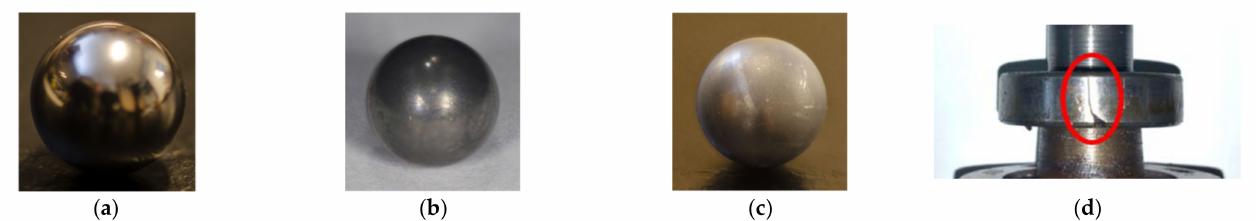
Figure 3. Representation of the wear for the fault of generalized roughness: ( a ) baseline, ( b ) step 1, ( c ) step 2. The bearing with the single-point defect (crack) is represented in ( d ).